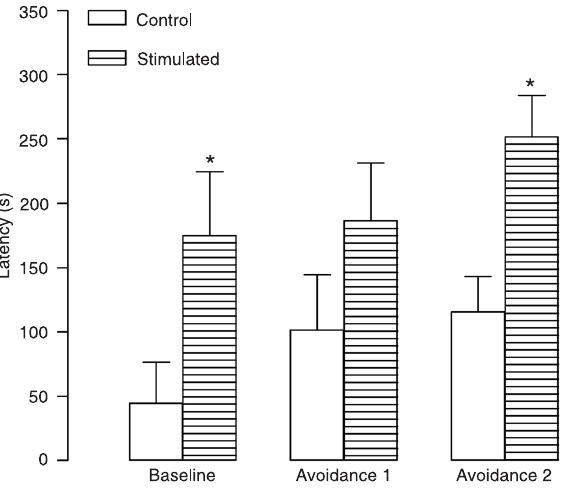
Figure 2. Effect (means ± SEM) of intra-dorsal periaqueductal gray matter injection of bicuculline (5 pmol) or saline on avoid- ance latencies measured in the elevated T-maze (N = 9-5). *P < 0.05 compared to the control group in the same trial (repeated measures ANOVA, followed by the Duncan test).